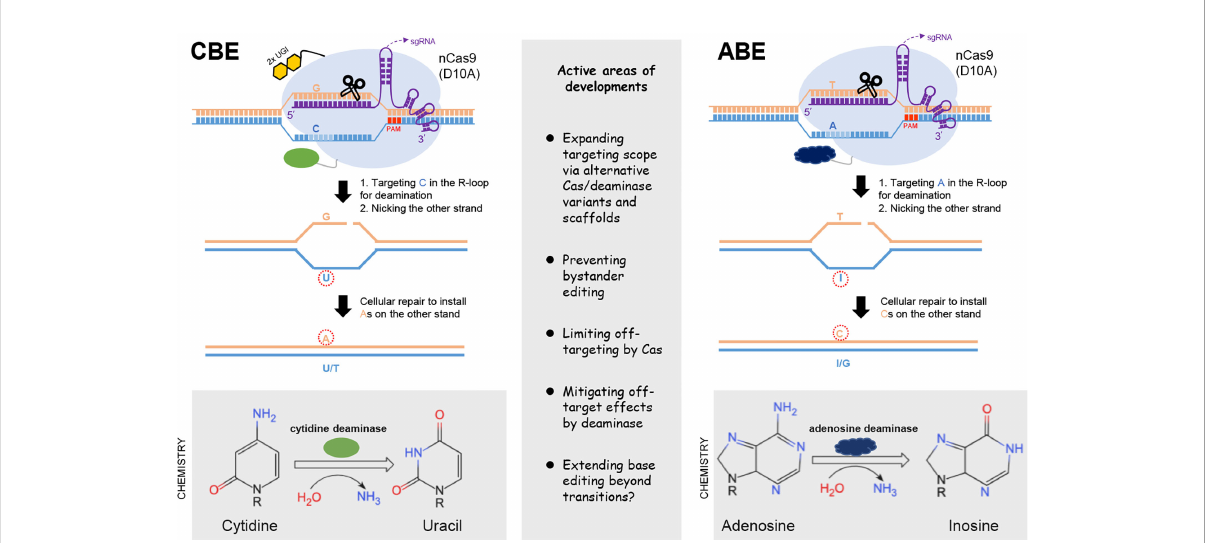
FIGURE 3 Base editing tools. The two major classes of base editors are illustrated on the left and right parts, respectively. CBE is constructed by fusing the Cas9 nickase (nCas9) with a cytidine deaminase enzyme, which targets the Cs within the exposed R-loop for conversion into U, the latter serving as a temporary surrogate for thymidine in base pairing properties. The uracil glycosylase inhibitor domains (2xUGI, in yellow) engineered to prevent base excision of the U are also shown. The activity window of the initially developed CBE often covers positions 4-8 (schematically indicated with light blue). The adoption of nCas9 in CBE is by design. Its activity would nick the unedited strand, thereby signaling the cellular repair to install the corresponding As on the complementary strand. The design of ABE follows similar principles, except for the employment of an evolved, DNA-targeting adenosine deaminase. Deamination of adenosine produces inosine, which serves as a temporary surrogate for guanosine. Note that no inhibitory domains against base excision of I are required for optimal ABE activities. Some key considerations for the current developments of base editors are summarized in the middle